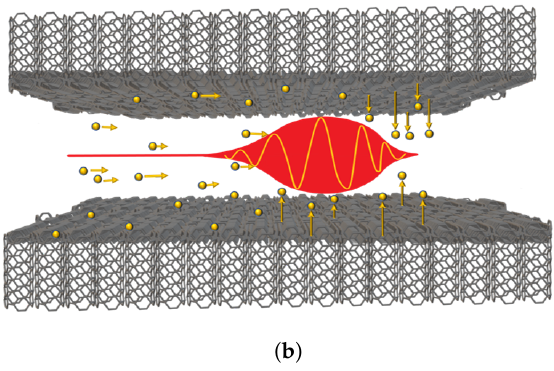
Figure 1. Illustration for proposed arrangement of carbon nanotubes to emulate high density plasma (not necessarily to scale). A laser pulse, shown in red, interacts with sheets of carbon nanotubes, shown in grey. The laser permeates the nanotubes, extracting and accelerating electrons, shown in yellow. Two arrangements are considered: ( a ) features CNTs arranged parallel to the laser propagation direction, and ( b ) features CNTs arranged perpendicularly to the laser propagation. The former case is treated for the majority of this